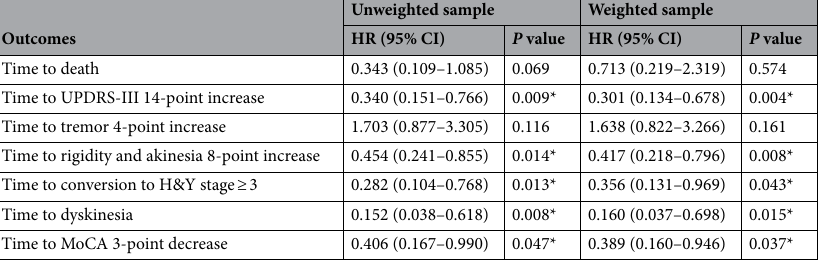
Table 2. Univariate Cox models for exploring the association between ET history and clinical outcomes of PD. ET: Essential tremor. PD: Parkinson’s disease. UPDRS: Unified Parkinson’s disease Rating Scale. H&Y stage: Hoehn and Yahr stage. MoCA: Montreal Cognitive Assessment. *Significant